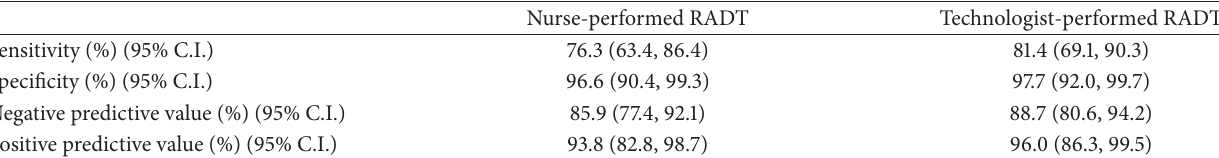
Figure 1: Participant flow. Table 1: Performance